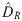
Primary school data set: Normalized temporal differences for the resistance distance D^R, edit distance D^E, and DeltaCon distance D^DC.